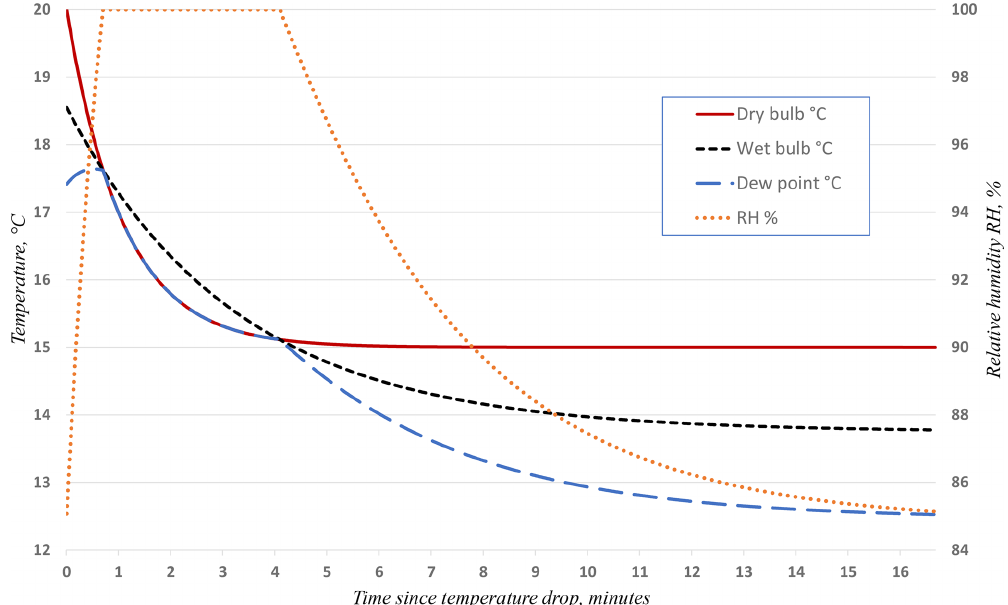
Figure 9. Time series (min) of dry-bulb, nominal wet-bulb, and calculated dew point temperatures ( ◦ C, left axis) and relative humidity (%RH, right axis) following an instantaneous fall in temperature of 5K from 20 ◦ C, assuming sensor response times per Table